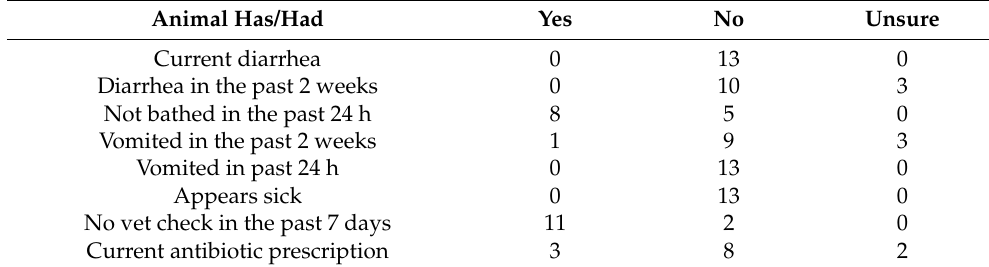
Table 3. Animal health and hygiene scenario-based questions “Would you permit an animal to visit if they had . . .